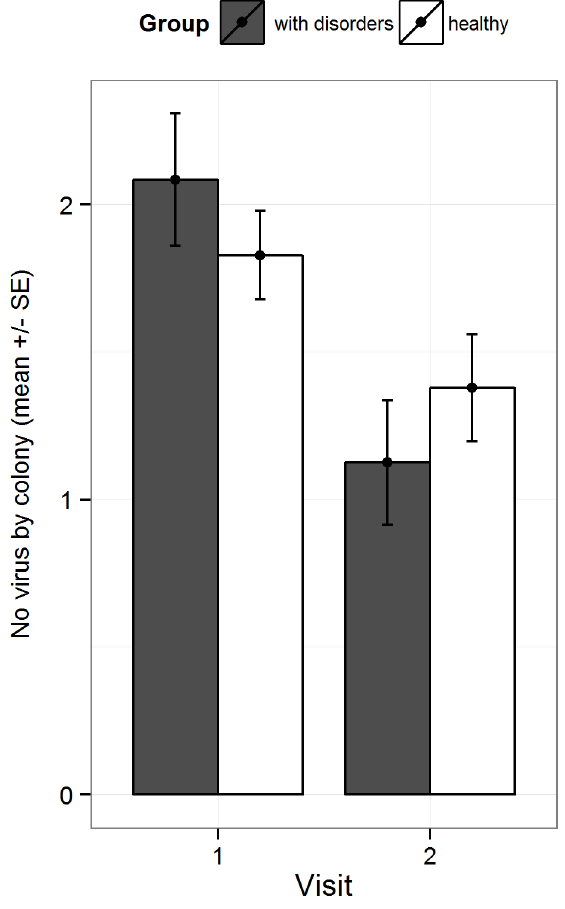
Figure 3. Average number of different viruses per colony. Data shown for the first and second visits (visit 1 - mid-July to mid-august and visit 2 - mid-September to mid-October) and the group with disorders (grey, n=24 colonies) and the healthy one (white, n=29 colonies). Whiskers show the standard error (SE).